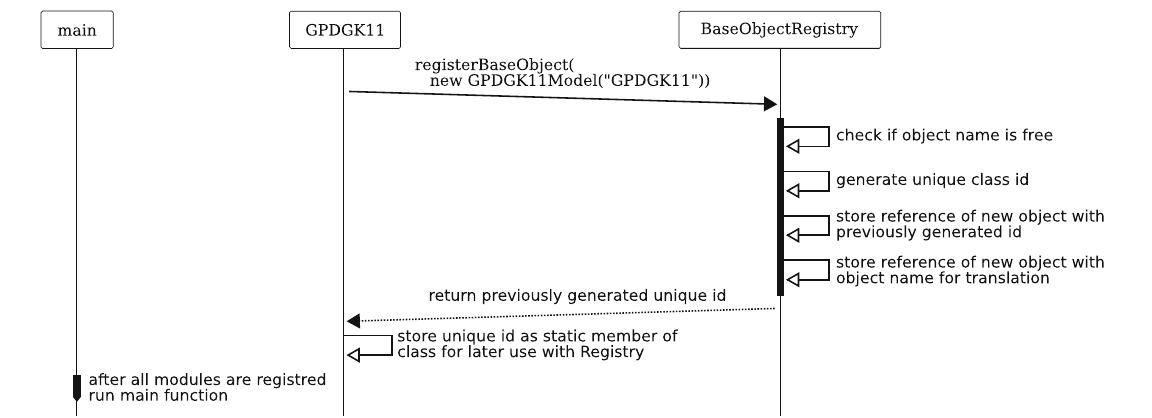
Fig. 6 Sequence diagram presenting the different steps, arranged in time, allowing the self-registration of all modules at the start of the exe- cutionofthePARTONScode.Parallelverticallines(lifelines)represent the different processes or objects simultaneously living. Vertical black